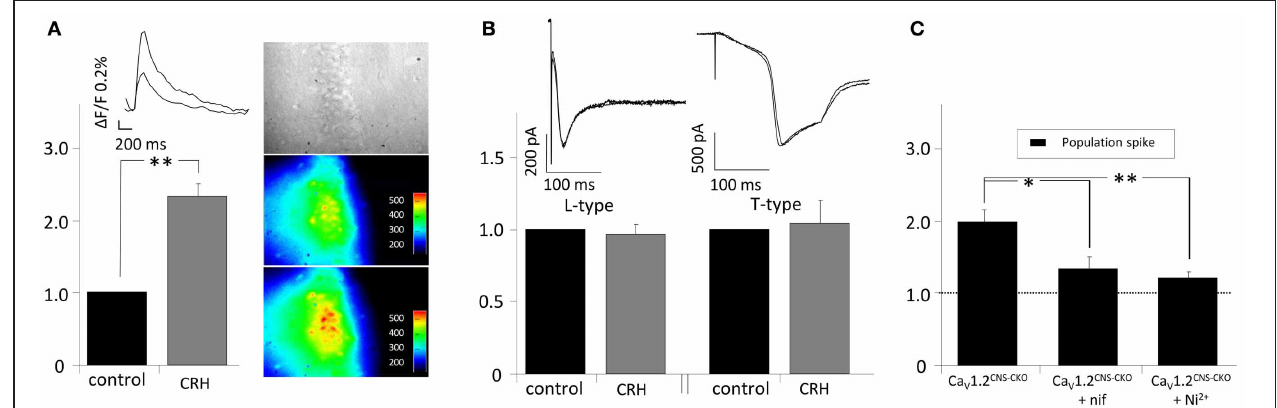
of 125nM CRH (lower inset). (B) Barium currents through T- and L-type calcium channels were recorded in single-cell voltage-clamp recordings. CRH did neither increase L-currents (96 . 8 ± 6 . 4% of control; n = 6; p > 0 . 05) nor T-currents (103 . 8 ± 16 . 4% of control; n = 7; p > 0 . 05). (C) PS amplitudes recorded from Ca V 1.2 CNS - CKO animals were increased to 197 . 3 ± 16 . 0% of control ( n = 3; p < 0 . 05). The effect of CRH on PS amplitude in CNS-CKO animals was diminished in the presence of the calcium channel antagonists nifedipine (132 . 3 ± 10 . 0% of control; n = 4; p < 0 . 05) or Ni 2 + (119 . 6 ± 5 . 9% of control; n = 5; p < 0 . 05). ∗ p < 0 . 05; ∗∗ p < 0 . 01.